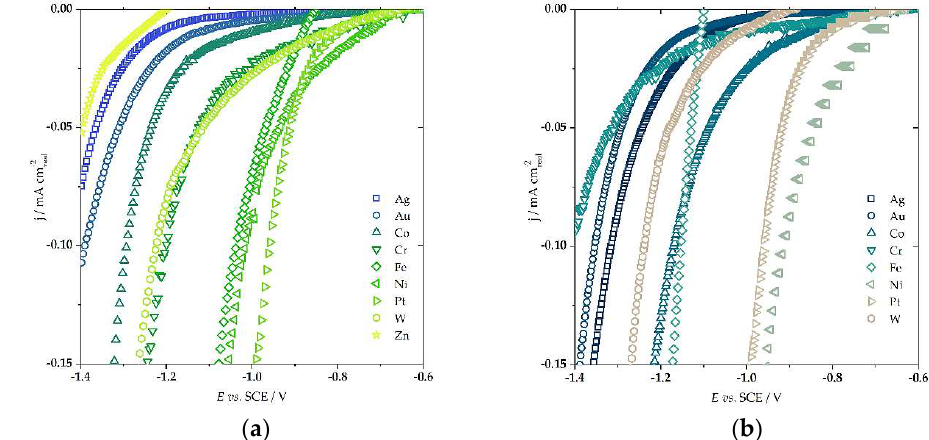
Figure 5. The HER polarization curves in 0.5 mol dm −3 NaCl of ( a ) freshly polished electrodes and ( b ) after oxidation to high anodic potentials. Please note that the HER activity of Zn was not possible to determine due to very active dissolution during the anodic treatment. Observe the inversion of Pt and Ni activity after the oxidative